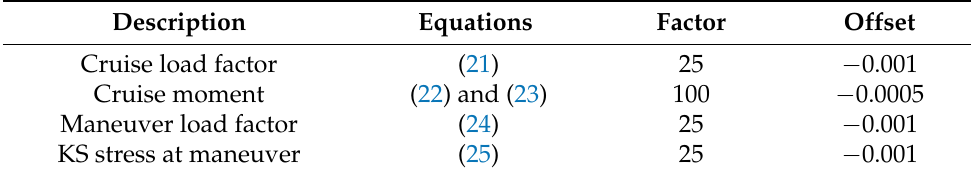
Table 4. Penalty factors and offsets for the different inequality